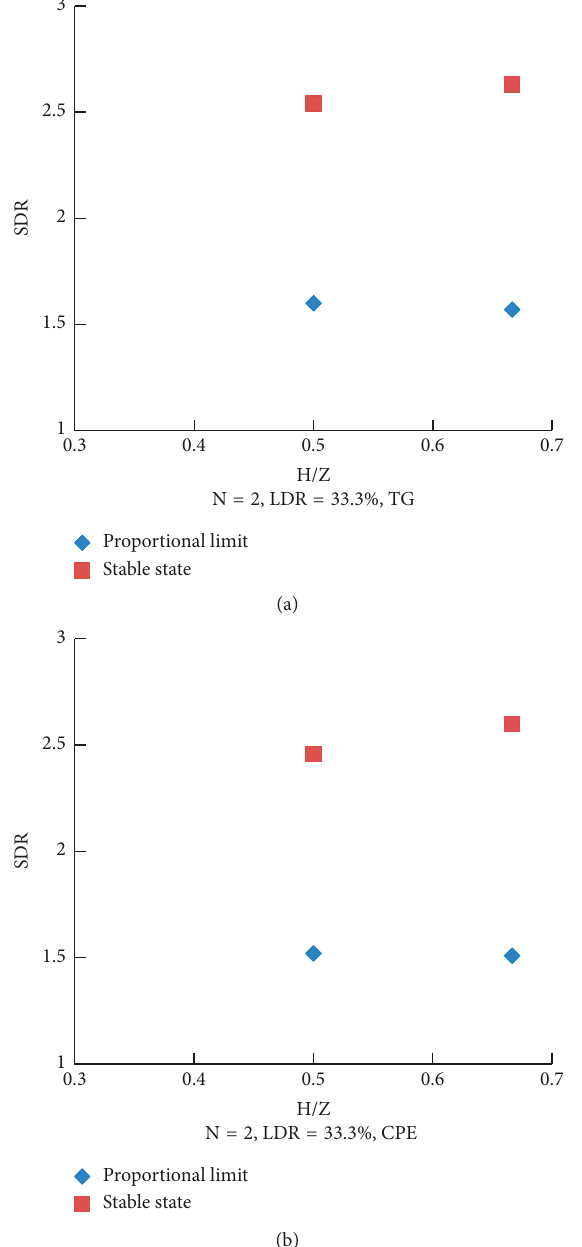
2; LDR (cid:30) (cid:30)